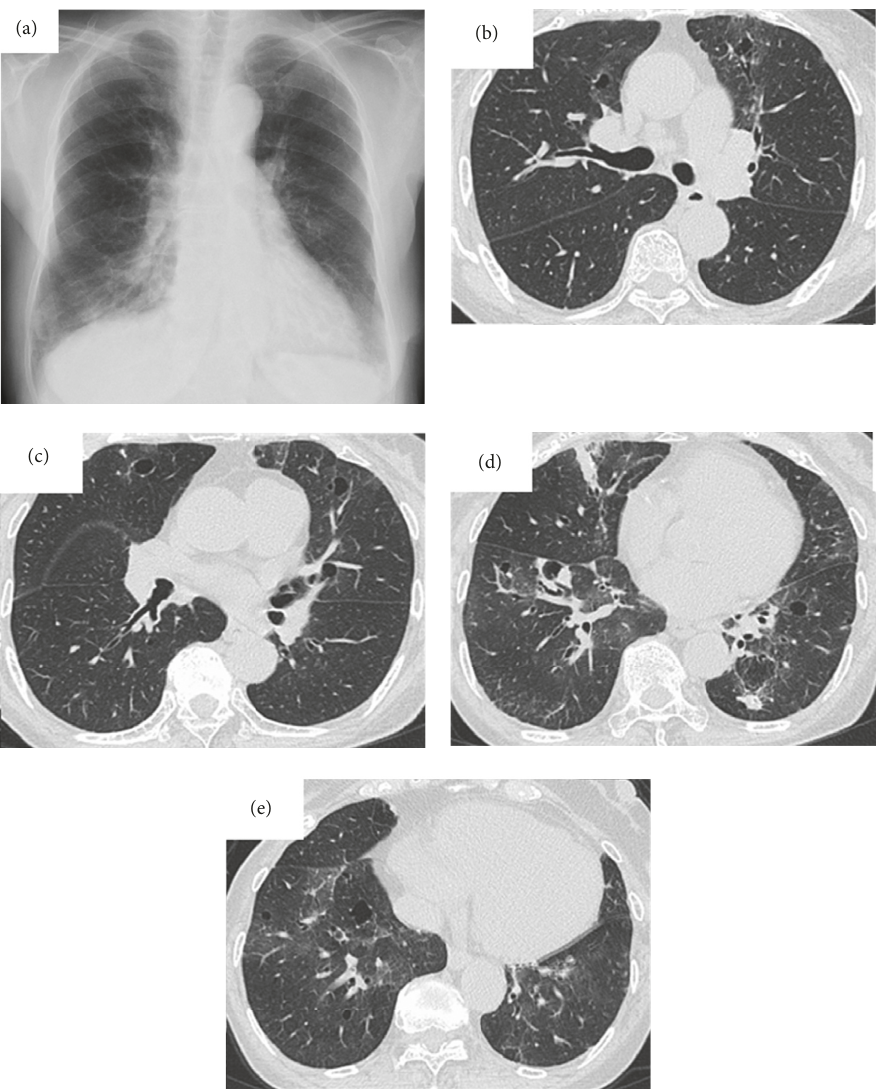
Figure 1: Chest radiograph and CT findings in a 72-year-old woman with Sj¨ogren syndrome and pulmonary amyloidosis. (a) Chest radiograph shows infiltrates in the right lower lung field and ground-glass shadows in the bilateral lower lung fields. Chest CTshows (b, c) multiple cystic lung shadows in the bilateral upper lobes, (d) infiltrates in the right middle lobe and a nodular shadow in the left lower lobe, and (e) ground-glass shadows in the bilateral lower lobes. CT, computed